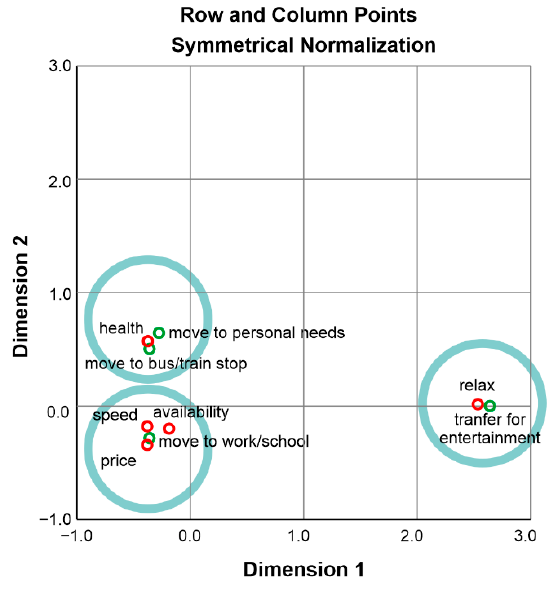
Figure 7. Correspondence map IV.